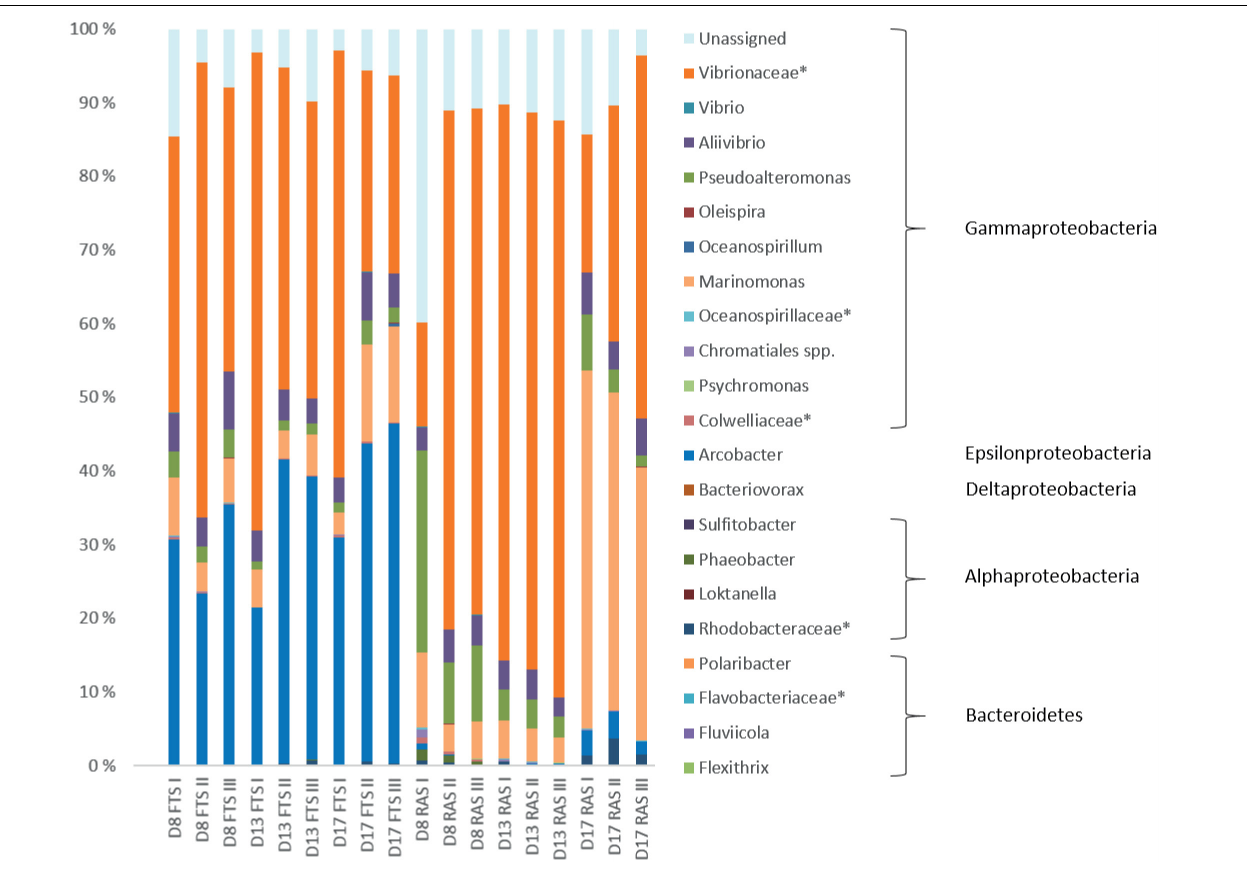
FIGURE 4 | Relative abundances of bacterial genera. Taxa that could not be classified at the genus level are marked by ∗ . Each sample represents RNA extracts from 25 pooled cod larvae at the age 8 dph, 17 pooled cod larvae at 13 dph and 10 pooled cod larvae at 17 dph (bars labeled D8, D13, and D17, respectively). Bars labeled FTS and RAS represent the flow through system and recirculation aquaculture system, respectively. Only genera represented by a proportion of ≥ 1% in at least one of the samples are shown.